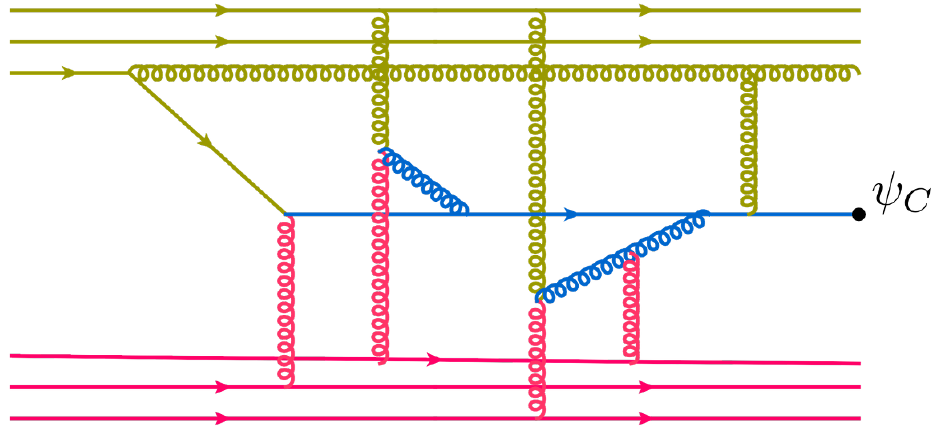
Figure 3 . Typical diagram for the classical (cid:12)eld with projectile/target sources. The Green func- tions of the central (cid:12)elds are given by retarded